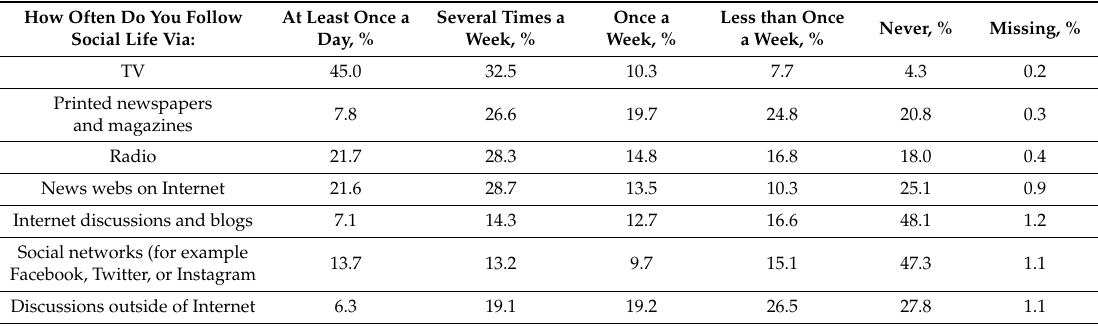
Table 4. Indicators—exposition to mass media and social discussion platforms when following social life. Frequency table